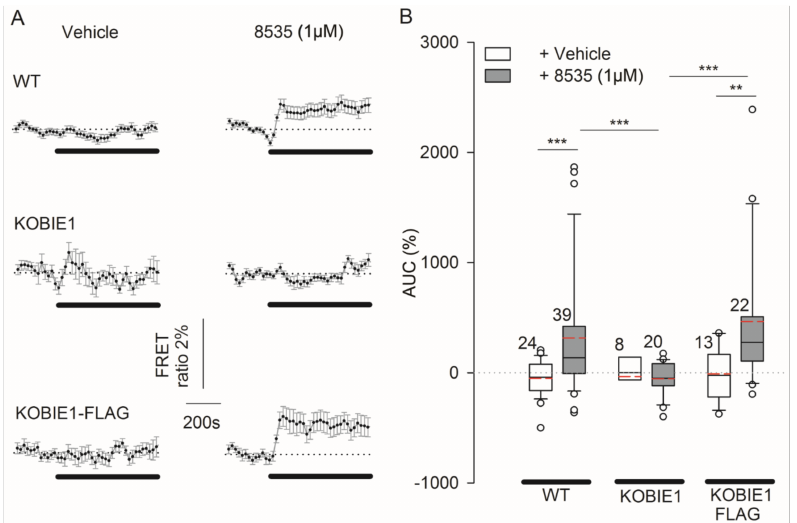
Figure 2. Optimization of co-transfection of plasmids Laconic and GPR27-FLAG into 3T3 cells. Immunocytochemistry of 3T3KOGPR27 cells co-transfected with Laconic and GPR27-FLAG (FLAG) plasmids and labeled with anti-FLAG antibody (see Methods). ( A ) Cells recorded under a Zeiss HAL 100 light source. Scale bars, 20 µ m. ( B ) Cells expressing plasmid Laconic. ( C ) Cells expressing plasmid GPR27-FLAG and stained with anti-FLAG antibodies. ( D ) Merged images of Laconic- and GPR27-FLAG-positive signals. Pixel value ranges from 0 to 255. ( E ) Co-localization of the Laconic and GPR27-FLAG plasmids, depending on different plasmid concentrations. ( F ) Co-localization of Laconic and GPR27-FLAG depending on different plasmid incubation times. The numbers adjacent to the bars are the number of cells analyzed.